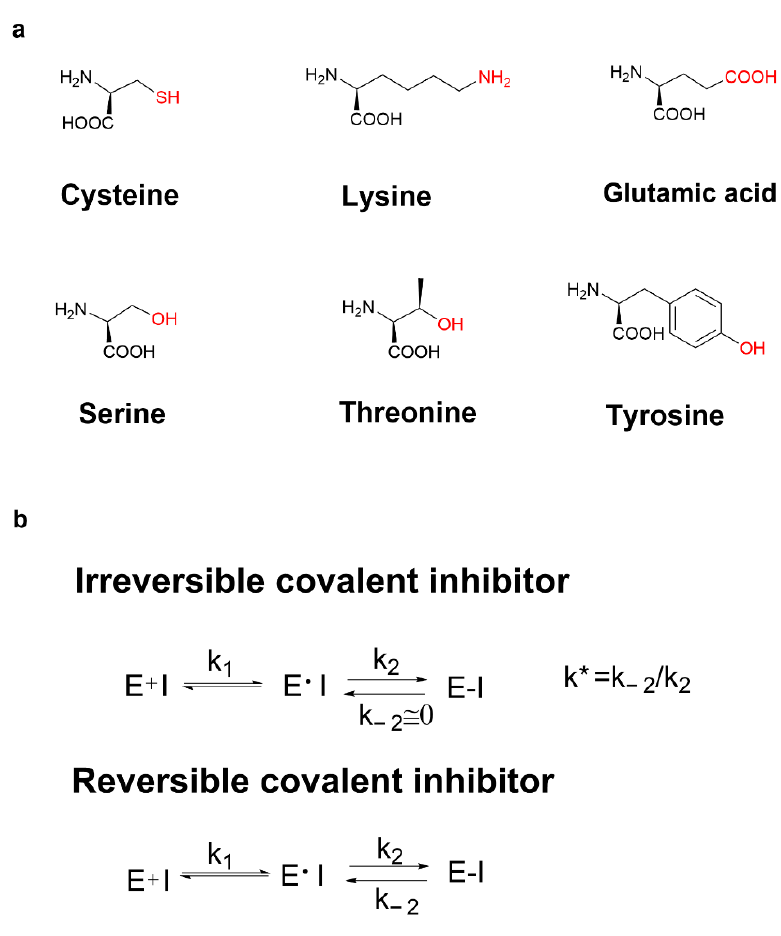
Figure 1. ( a ) The covalent reaction-related residues; ( b ) mechanism action of irreversible covalent inhibitors and reversible covalent inhibitors.